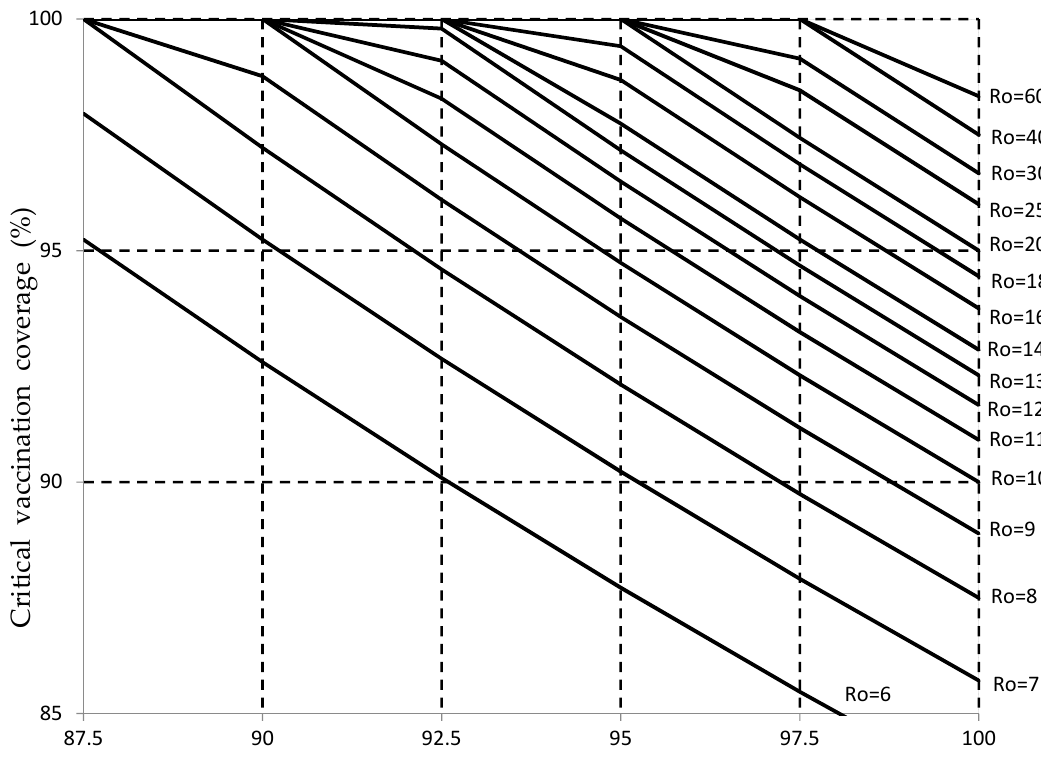
Figure 1. The vaccination coverage (%) required to establish herd immunity for measles viruses with reproductive numbers (Ro) from 6 to 60 and the effectiveness of measles vaccination from 87.7% to 100%. The objectives of measles vaccination coverage with two doses of vaccine of 95% (proposed by the WHO European Region at the national level), and 90% are indicated by horizontal dashed lines.